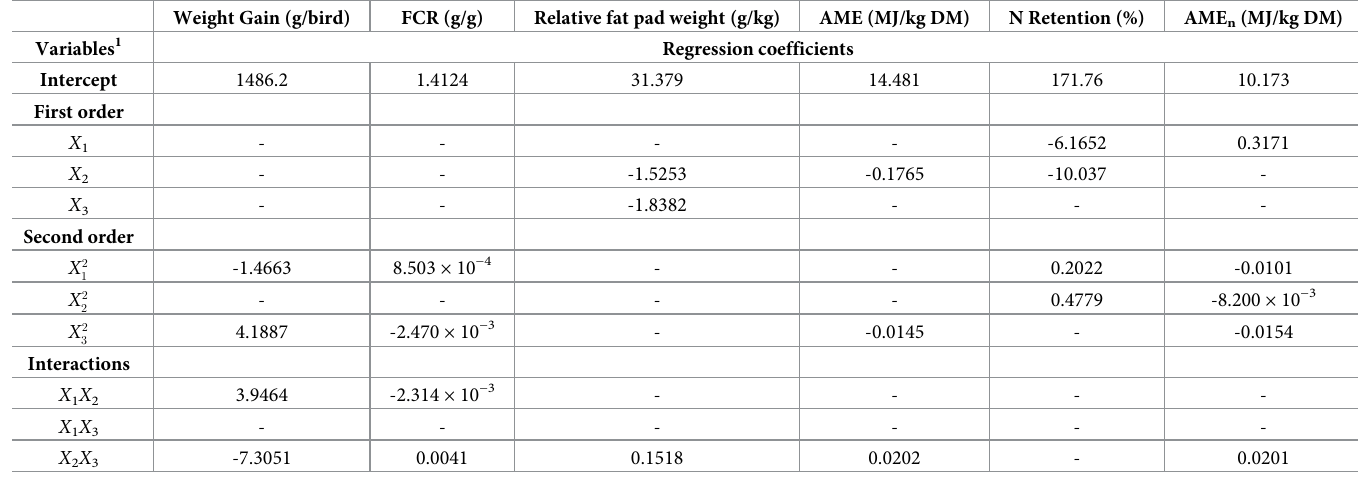
Table 9. Polynomial fitted model (P < 0.05) equations for growth performance from 7 to 28 days post-hatch and nutrient utilisation from 24 to 27 days post-hatch. Weight Gain (g/bird)